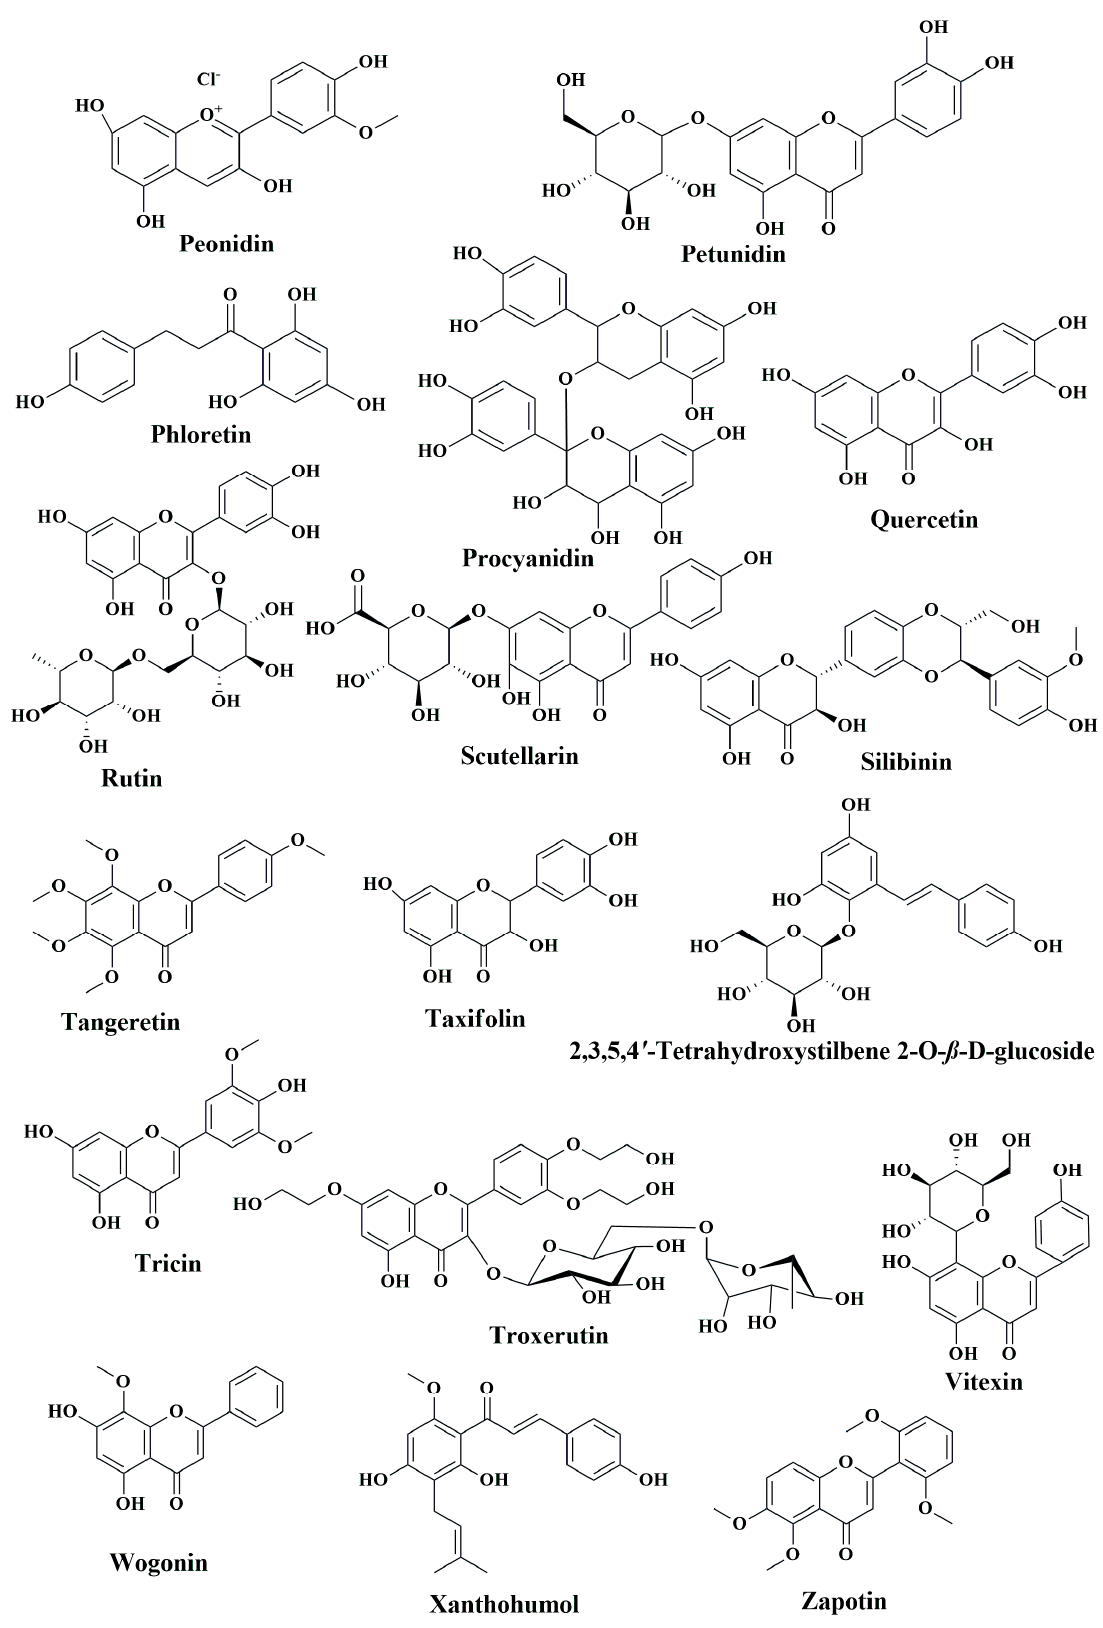
Figure 2. Chemical structures of flavonoids with in vivo anti-CRC activities.